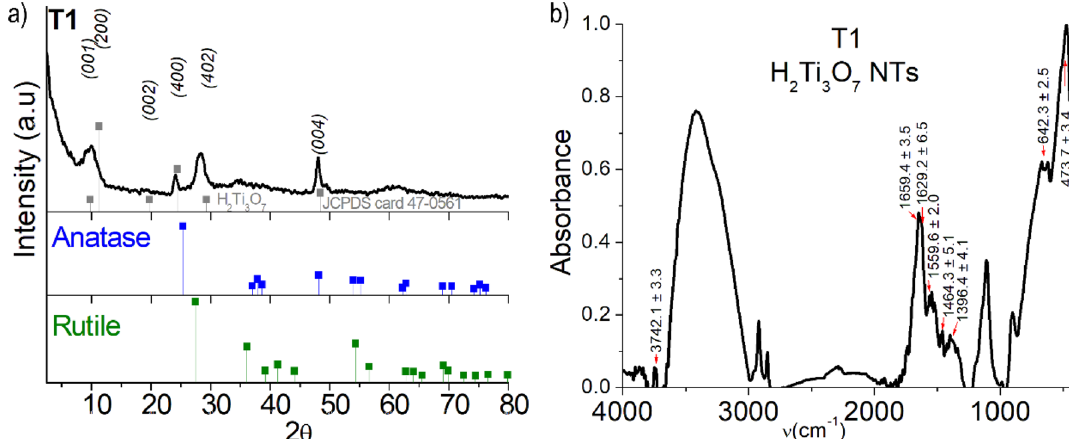
Figure 3. ( a ) X-ray diffraction (XRD) of T1 (black line), H 2 Ti 3 O 7 patterns (JCPDS card 47-0561) (grey line), TiO 2 anatase (blue line) (JCPDS card 89-4921), and TiO 2 rutile (green line) (JCPDS card 89-8304). ( b ) Normalized IR spectrum of T1 in the range of 450–4000 cm −1 showing the typical bands of water and